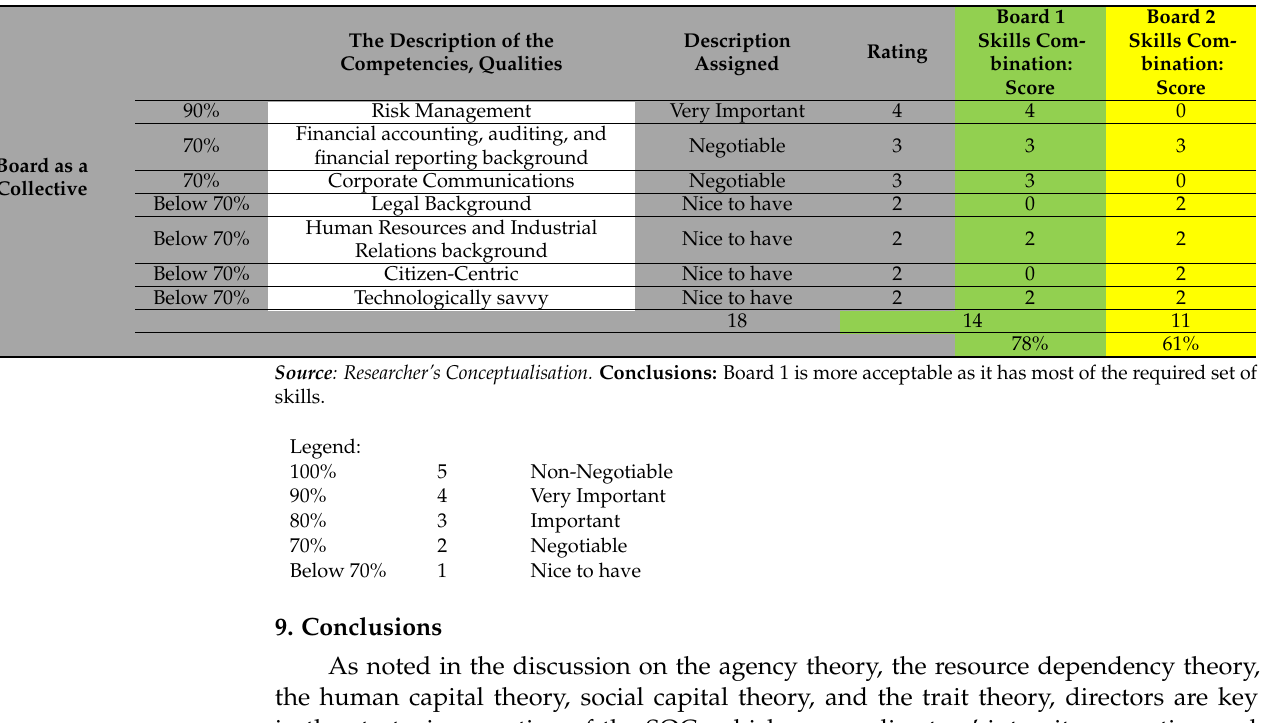
Table 5. Illustrative example showing how to score competencies and qualities of board of